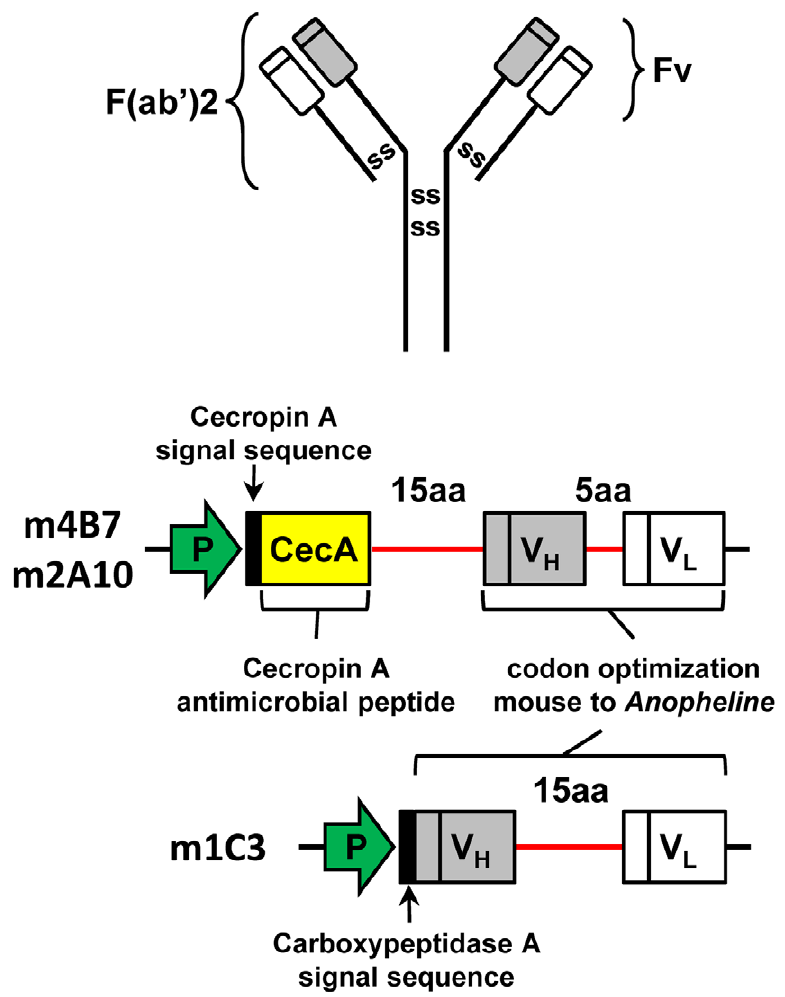
Figure 1. A model of the modified scFv transgenes. A mature mouse immunoglobulin molecule consists of two heavy- and light-chain polypeptides each linked through disulfide (ss) bonds (top image). The single-chain antibodies are composed of the variable regions (Fv) of the heavy (V H ) and light (V L ) chains (gray and open boxes, respectively) of a mouse monoclonal antibody. The m4B7 and m2A10 scFv transgenes encode a short polypeptide linker of 5 amino acids (5aa) between V H and V L . These transgenes include sequence for a long polypeptide linker of 15 amino acids (15aa) joining the V H to the An. gambiae Cecropin A peptide (CecA), including its signal sequence. The V H region present in the m1C3 transgene is joined to the An. gambiae Carboxypeptidase A gene signal sequence, and joined by a long polypeptide linker to the V L region. Select codons in the variable region genes were codon-optimized to facilitate efficient translation. Anopheles promoter sequences (P) were joined to the scFvs to direct tissue-specific transgene